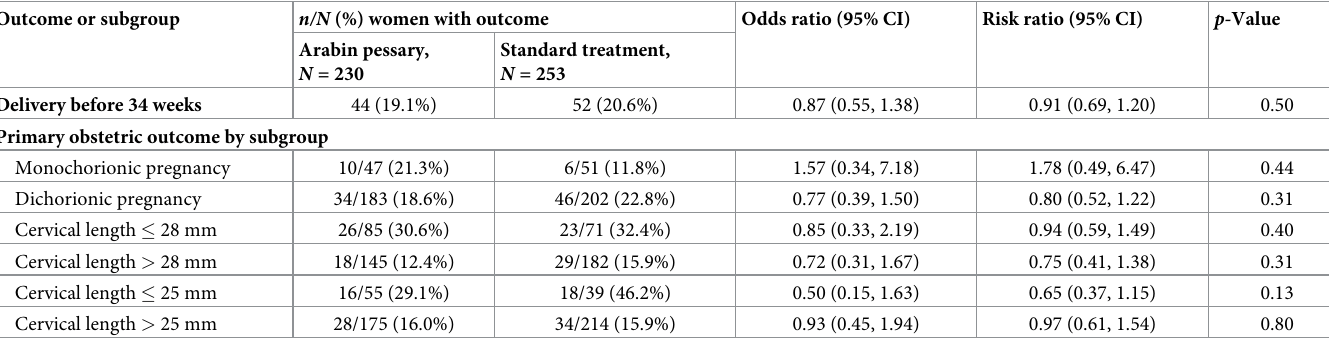
Table 6. Primary obstetric outcome and key subgroup analyses per protocol